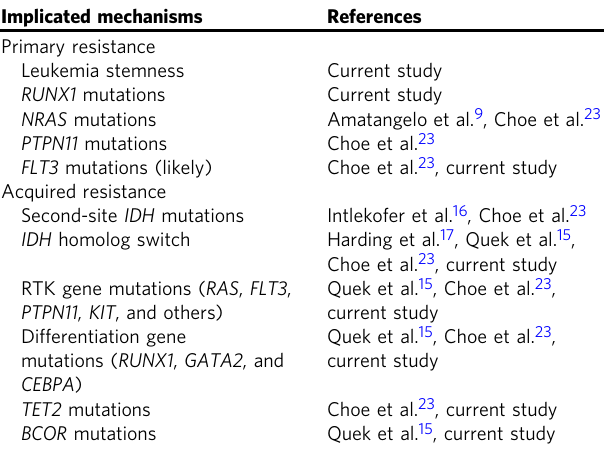
Table 3 A summary of available evidence for the association between molecular alterations and IDHi resistance, including the result from the current